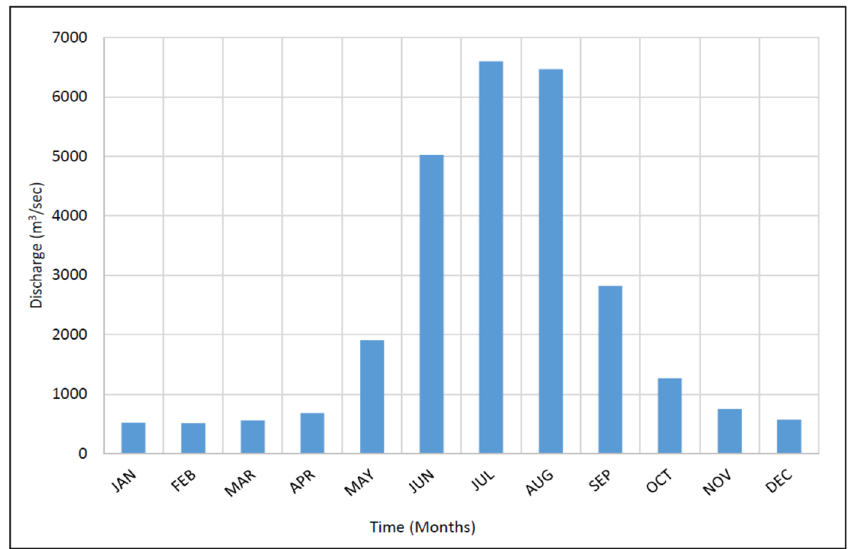
Figure 7. Mean Monthly Inflow Hydrograph at Besham Qila (2008–2020).